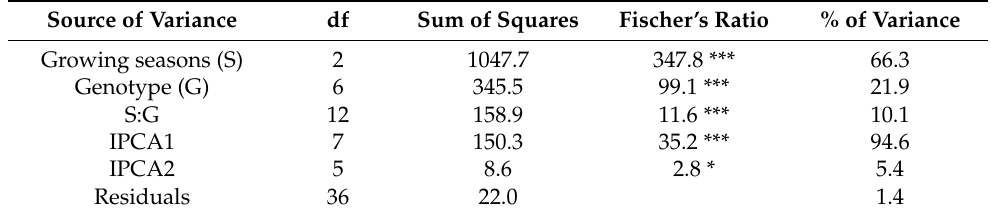
Table 3. AMMI analysis of variance on the anthesis of 100 wheat varieties evaluated in three growing seasons (2016–2019).